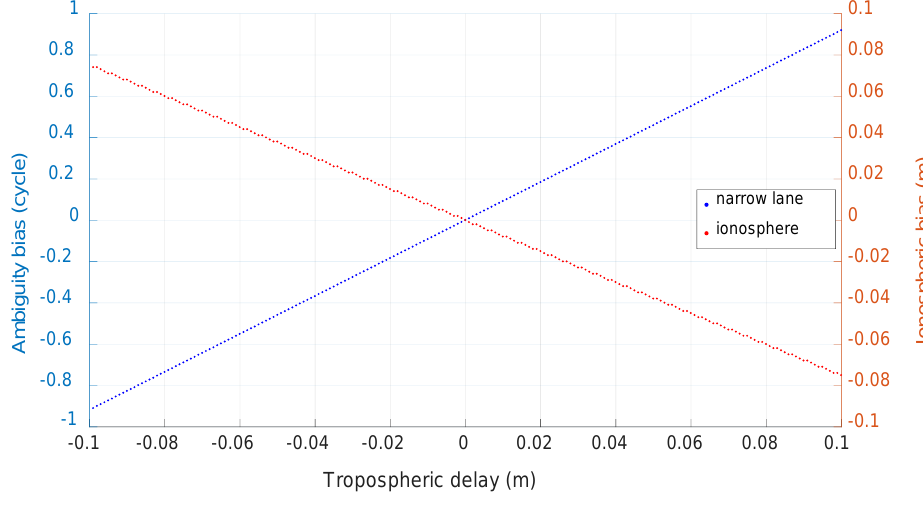
Note that tropospheric delay is also ignored and its effect on ambiguity resolution is shown in Figure 22. We can see that the effect is obvious, the bias of narrow-lane ambiguity can reach about 0.918 cycle with ignored tropospheric delay of 0.1 m and 0.183 cycle with tropospheric delay of 2 cm.